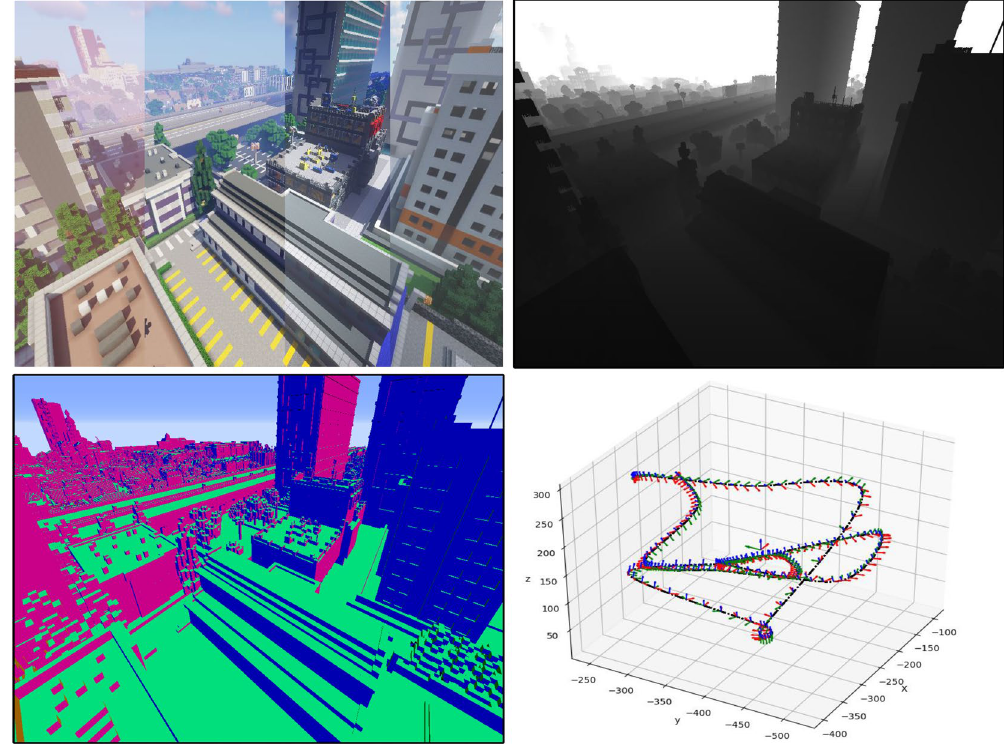
Figure 1. MineNavi dataset provides image sequence, depth map, surface normal map and camera 6 DoF pose in the large scale scene (with over 576 m